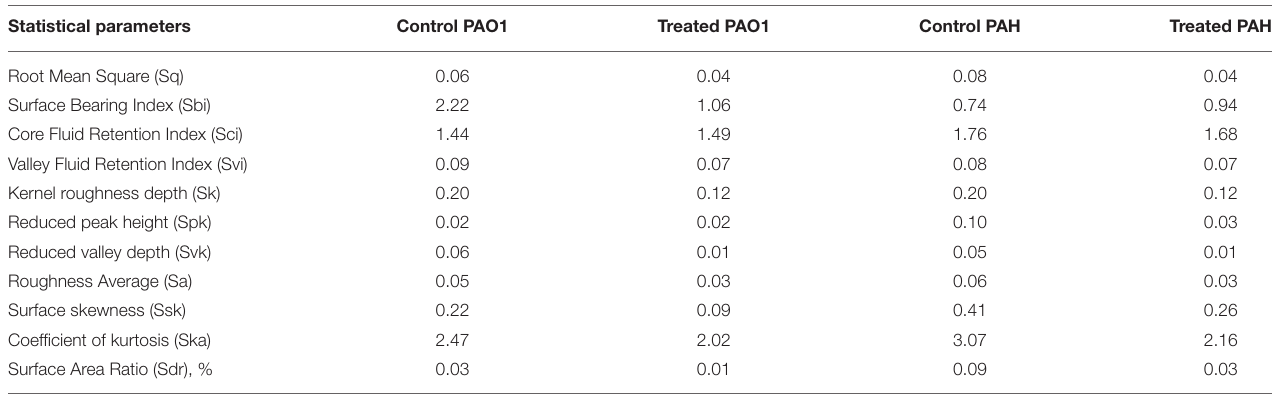
TABLE 1 | Statistical analysis of biofilm analyzed by atomic force microscopy (AFM). Statistical parameters Control PAO1 Treated PAO1 Control